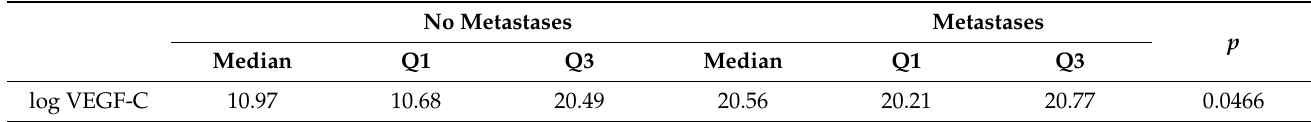
Table 6. VEGF-C tumor levels in patients with and without distant metastases. Mann–Whitney U